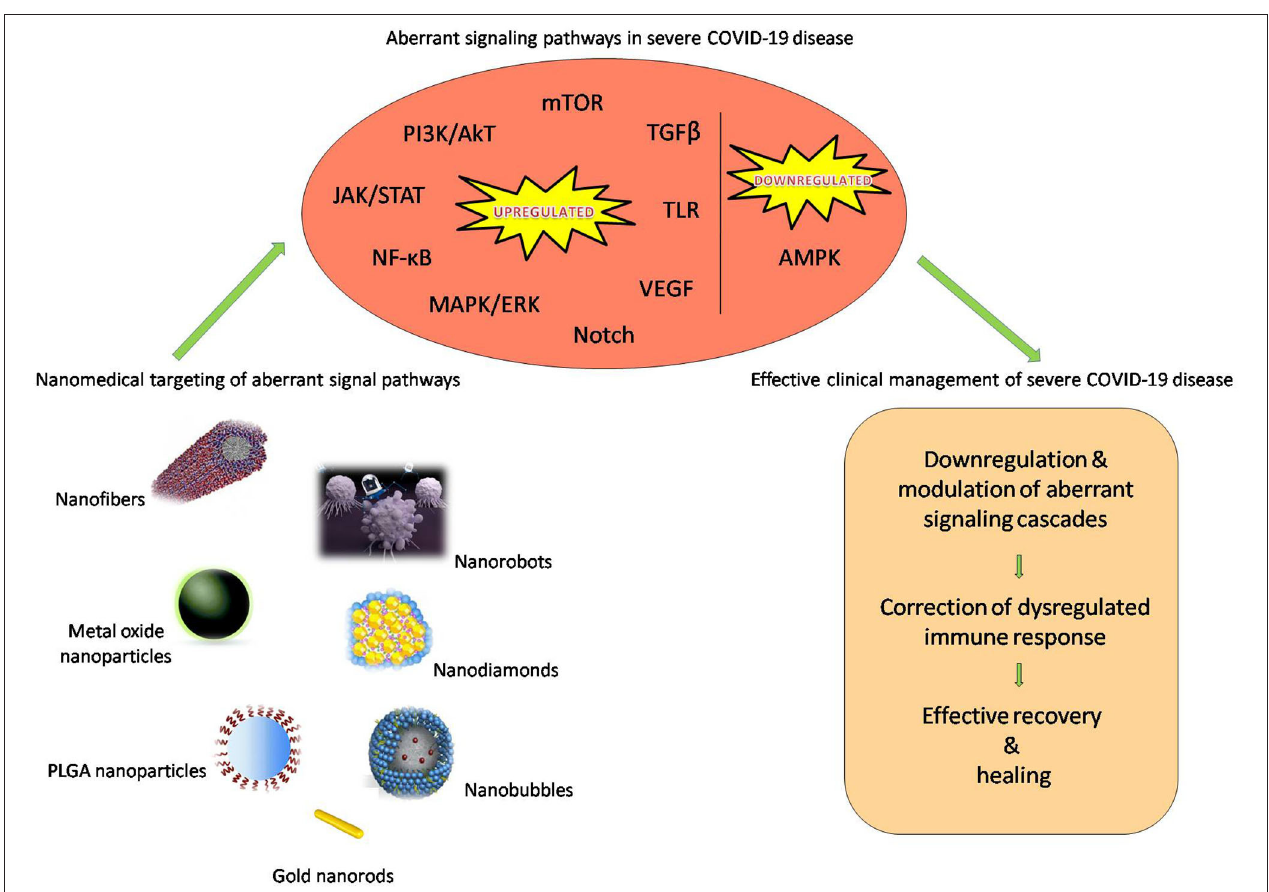
FIGURE 2 | Nanomedical targeting of the aberrant signaling cascades in